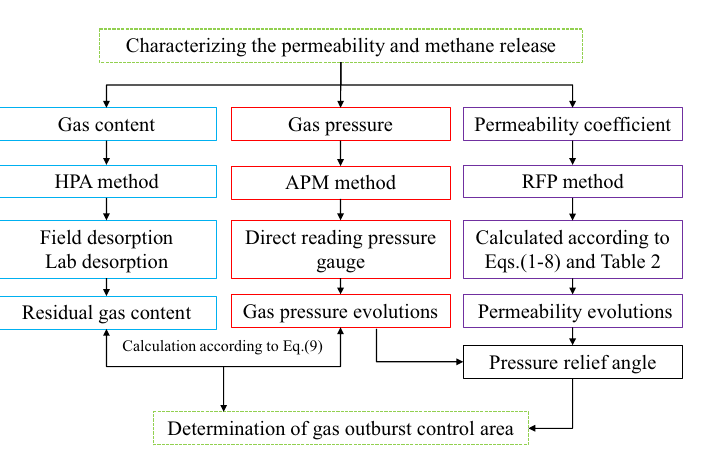
Figure 15. Field measurement flow chart for Characterizing the permeability and methane